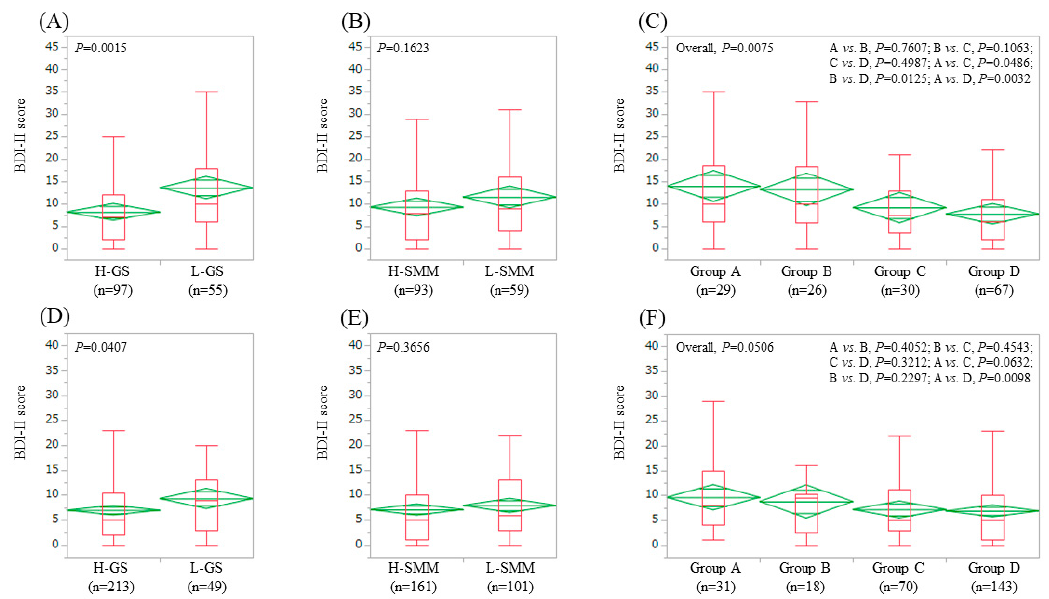
Figure 2. BDI-II score stratified by GS and SMM for LC cases ( n = 152). ( A ) Lower GS (L-GS) vs. Higher GS (H-GS). ( B ) Lower SMM (L-SMM) vs. Higher SMM (H-SMM). ( C ) Comparison among four types (group A, B, C and D). BDI-II score stratified by GS and SMM for non-LC cases ( n = 262). ( D ) L-GS vs. H-GS. ( E ) L-SMM vs. H-SMM. ( F ) Comparison among four groups (group A, B, C and D). Group A indicates L-GS and L-SMM. Group B indicates L-GS and H-SMM. Group C indicates H-GS and L-SMM. Group D indicates H-GS and H-SMM.